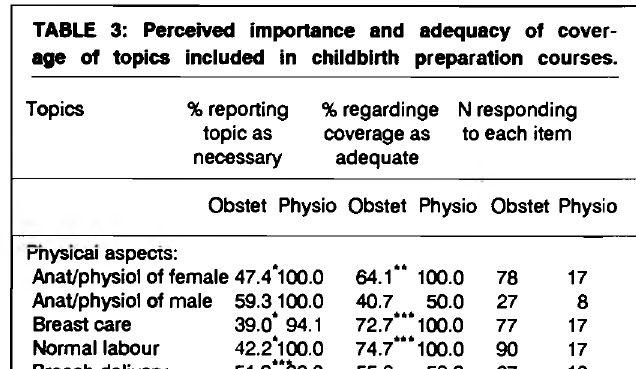
TABLE 3: Perceived importance and adequacy of cover­ age of topics included in childbirth preparation